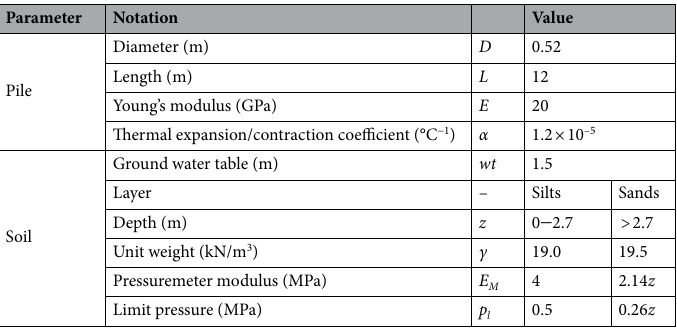
Table 1. Deterministic parameters for pile and soil. Data from Szymkiewicz et al. 36 and Habert et al. 35 .